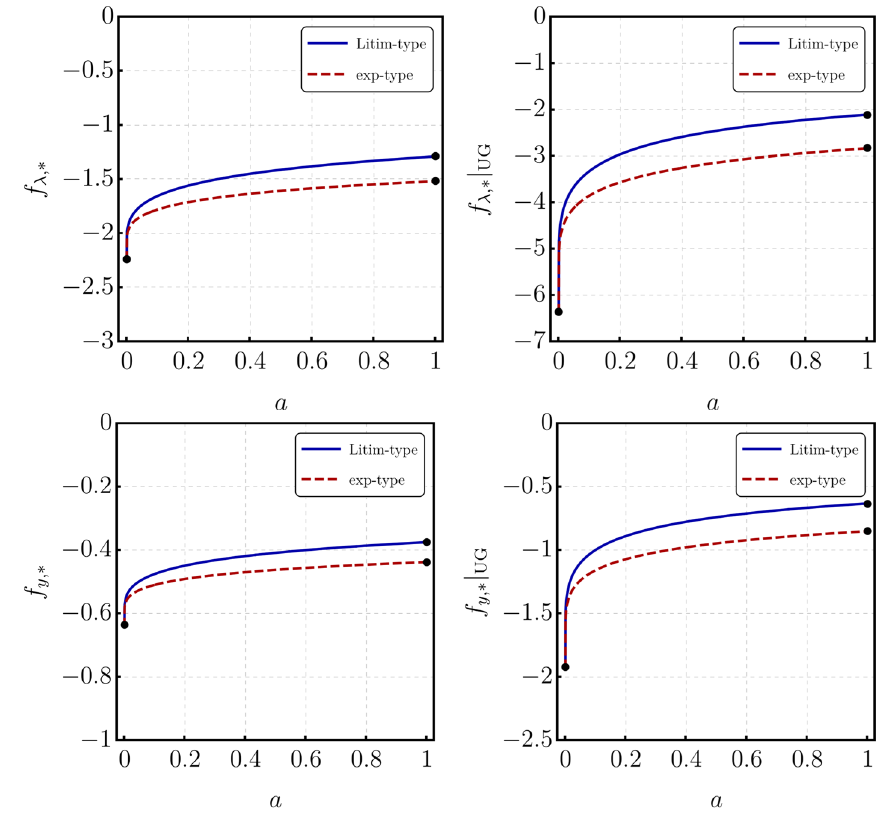
contributions in the limit a →